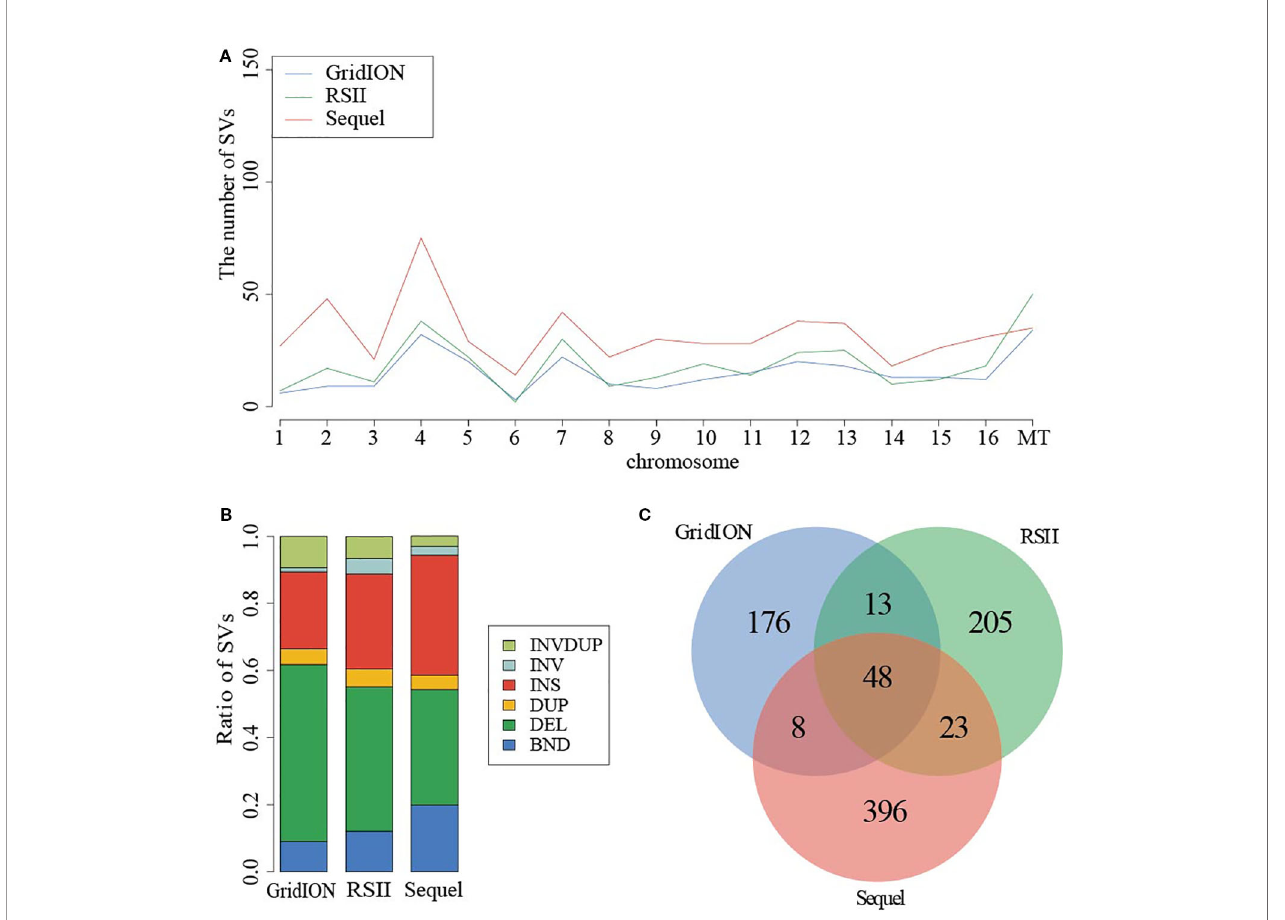
FIGURE 2 | Comparison of SVs in PacBio and ONT sequencing platforms. (A) The distribution of SVs in chromosome. (B) The ratio of SV types from three instruments. (C) The common SVs among three